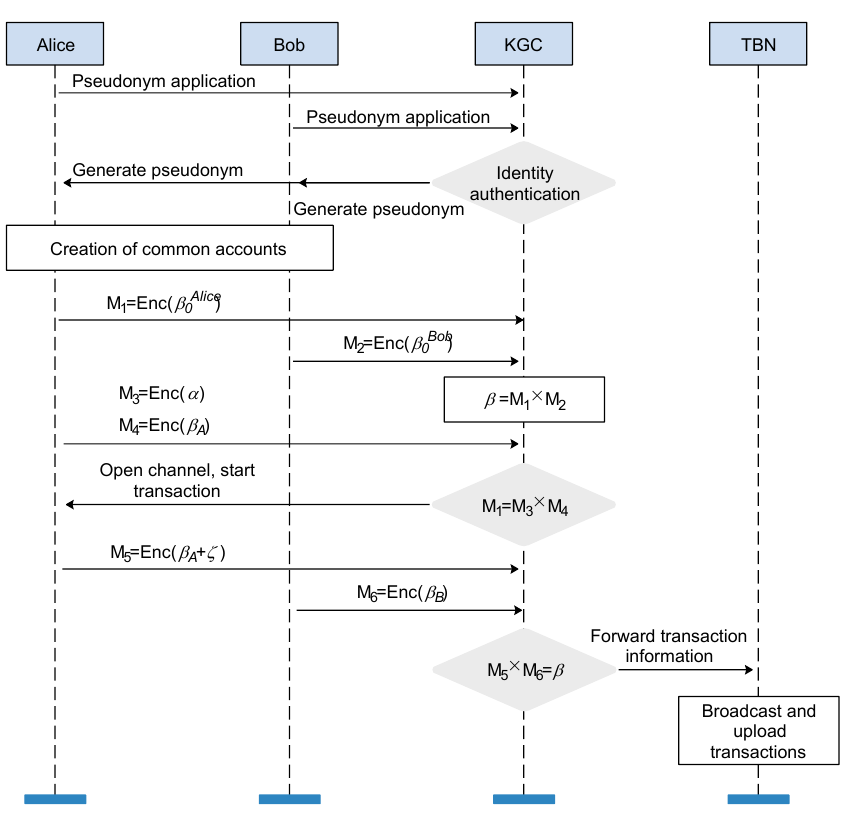
Figure 6. Overall flow of